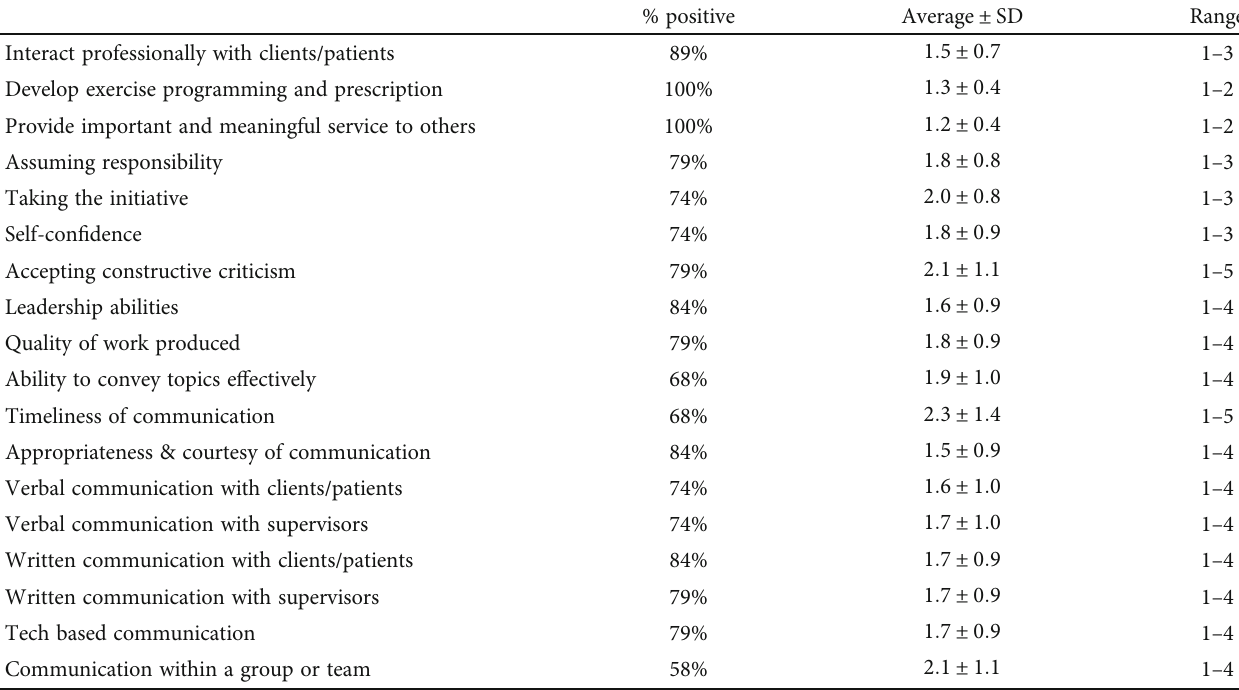
Table 1: Undergraduate student professional competency improvement.